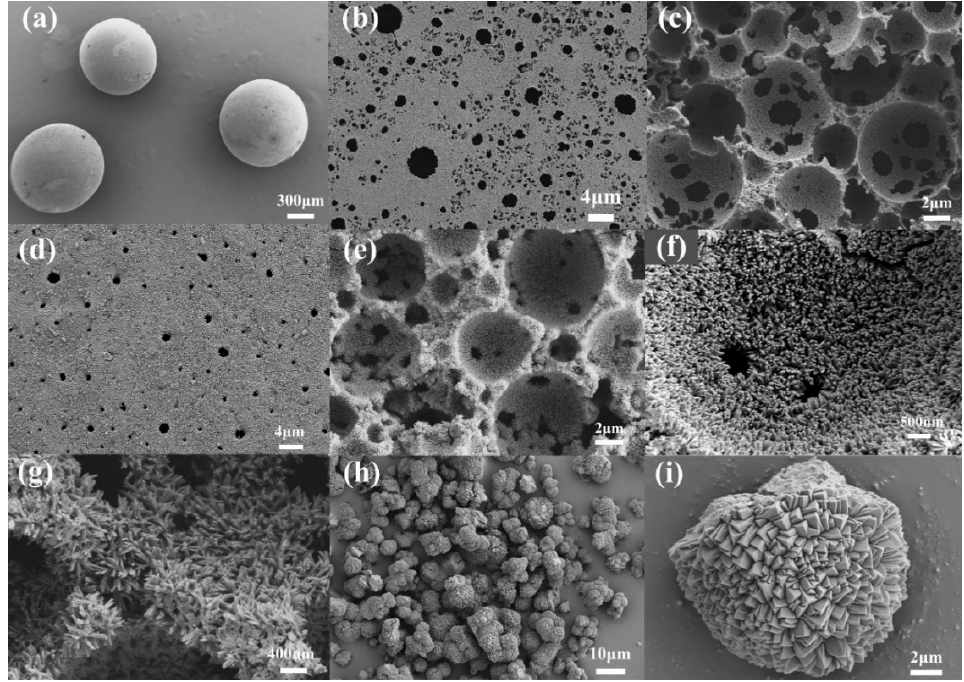
Figure 6. SEM images of ( a ) Ni−MOF−74@PA−PEI and ( b ) the PA surface. The internal pore structure of the ( c ) PA and ( d ) Ni−MOF−74@PA−PEI surface. The internal pore structure of ( e – g ) Ni−MOF−74@PA−PEI and ( h , i ) pristine Ni−MOF−74 at different magnifications.